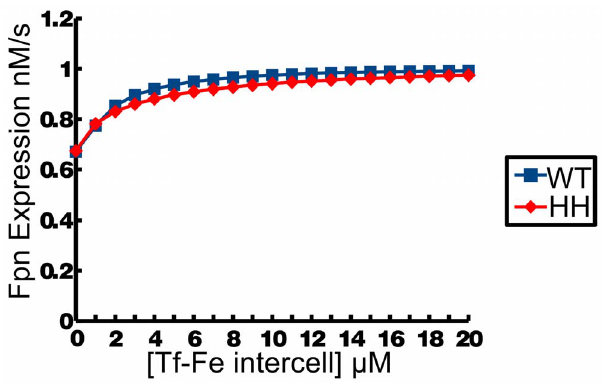
Figure 4. Ferroportin expression rate in the model doubles in response to changing serum iron concentrations as verified experimentally. HFE knock-down (HH) simulations and WT simulation of Fe-Tf against ferroportin (Fpn)